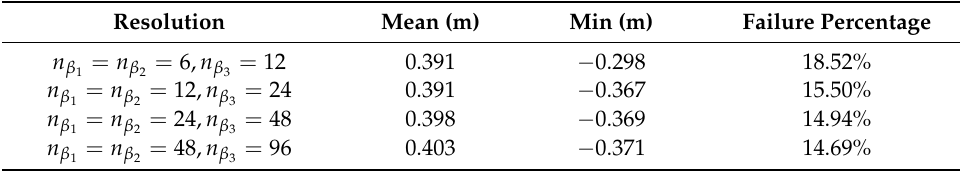
Table 1. Controllability Analysis Results For Different Query Point Resolutions.